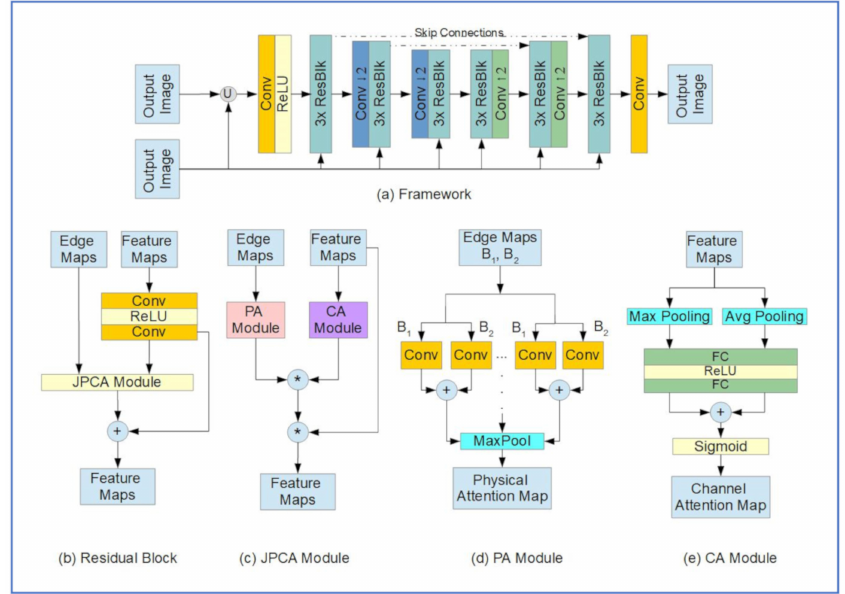
Figure 22. The Structure of the Joint Physical Shape/Channel Attention Raindrop Removal Algorithm (Quan et al.